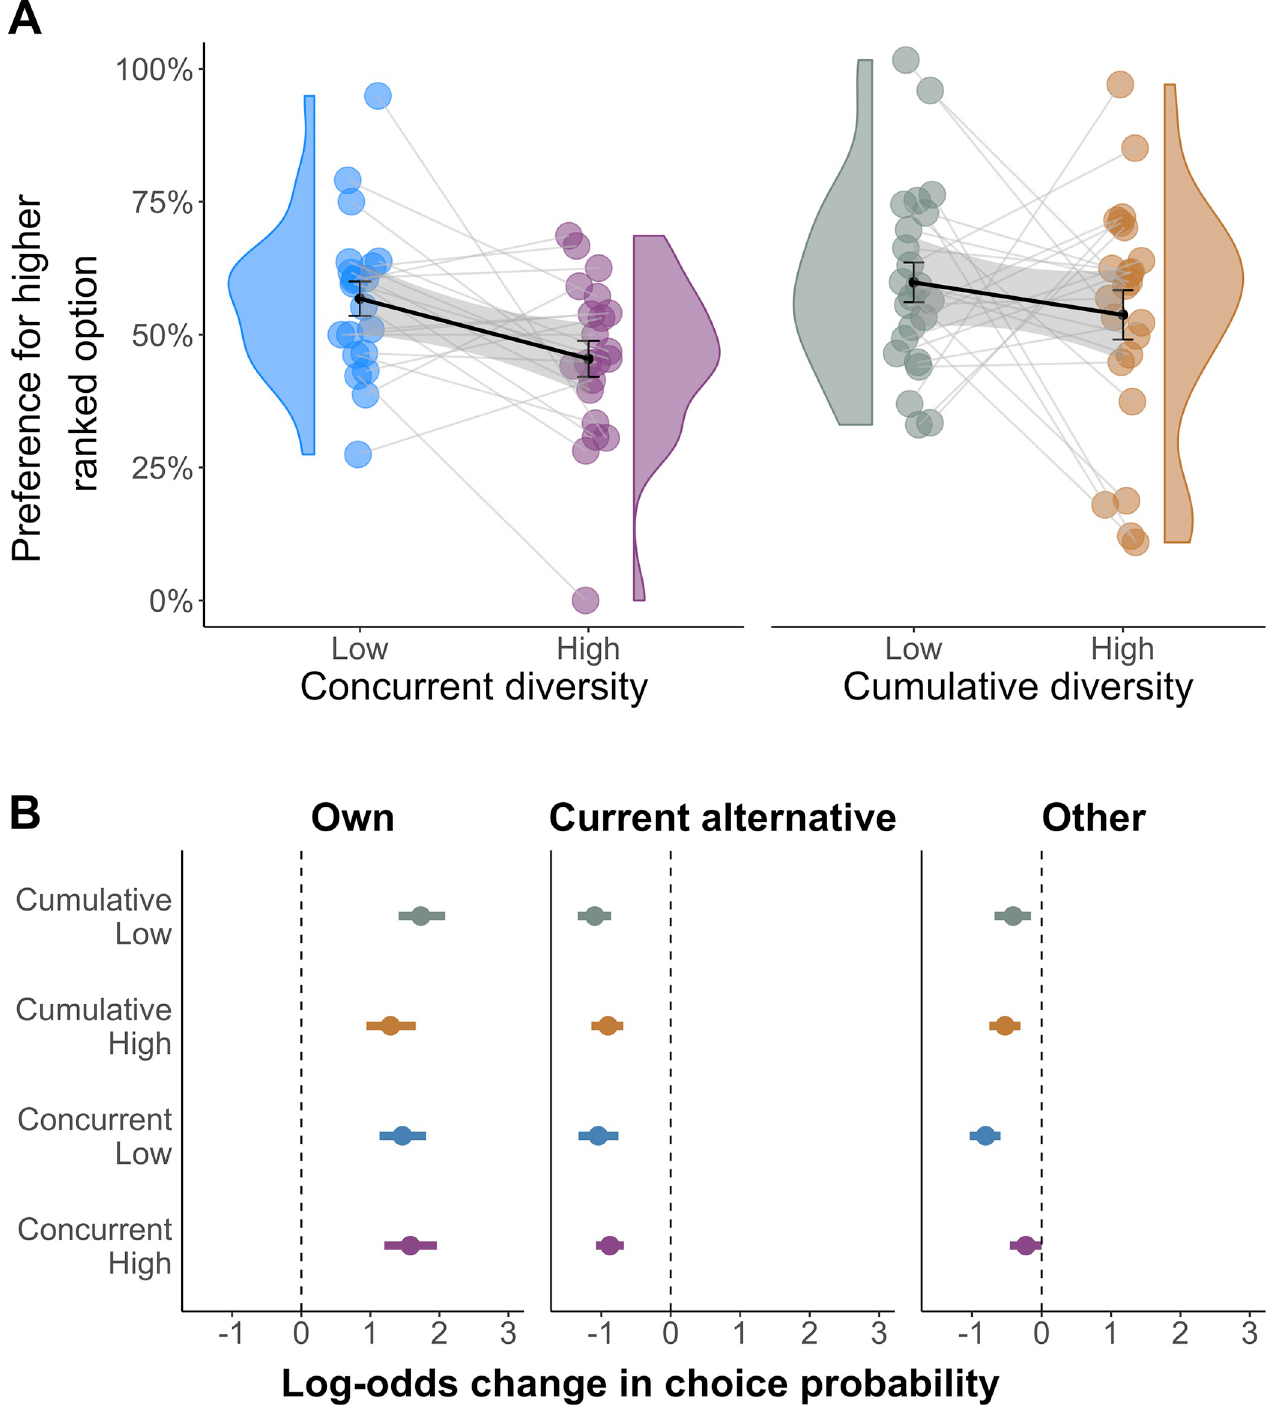
Fig 4. Effect of other options’ outcomes. A) Rank bias as a function of training diversity. Y-axis shows the percent of trials involving similarly rewarded images in which subjects chose the image that ranked higher during learning. A subject’s image rankings were based on how many times the subject chose each image over the other images it was pitted against (best, second-best, or worst, see Methods for further details). The plot depicts individual subjects’ choices (circles), group distributions (violin), group means (thick lines) and standard errors (gray shading). B) Effect of reward histories on choice. The plot shows the log odds effect on choice of three types of reward. Own: differences in reward history of currently available images. Current alternative: differences in reward history when rejecting one available image in favor of the other available image. Other: differences in reward history when rejecting one of the available images in favor of any other